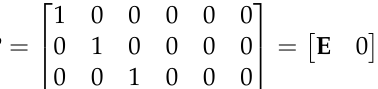
Phase coordinates are the most natural description of three-phase power systems. Figure 5. Original circuit of the power transmission